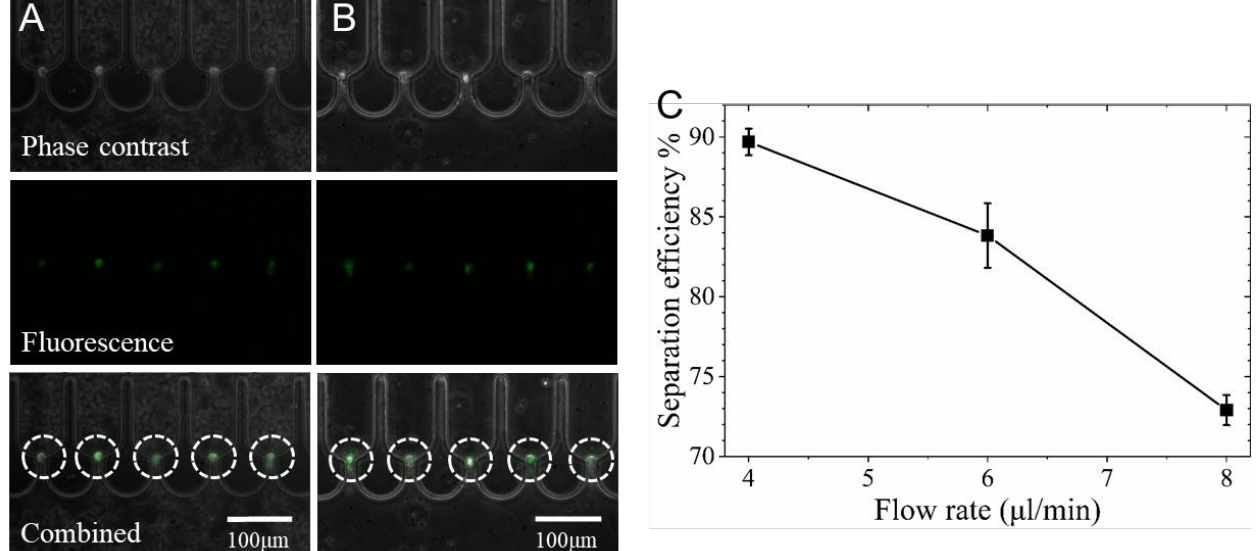
Figure Figure 5. The separation of K562 cells in mouse whole blood using a microdevice with 100 μm deep filtration channels. The phase contrast, fluorescent, and combined images of isolated K562 cells (highlighted in dotted circles) ( A ) in whole blood and ( B ) in PBS after rinsing of blood cells at 4 μL/min . ( C ) The separation efficiency at various inlet flow rates.